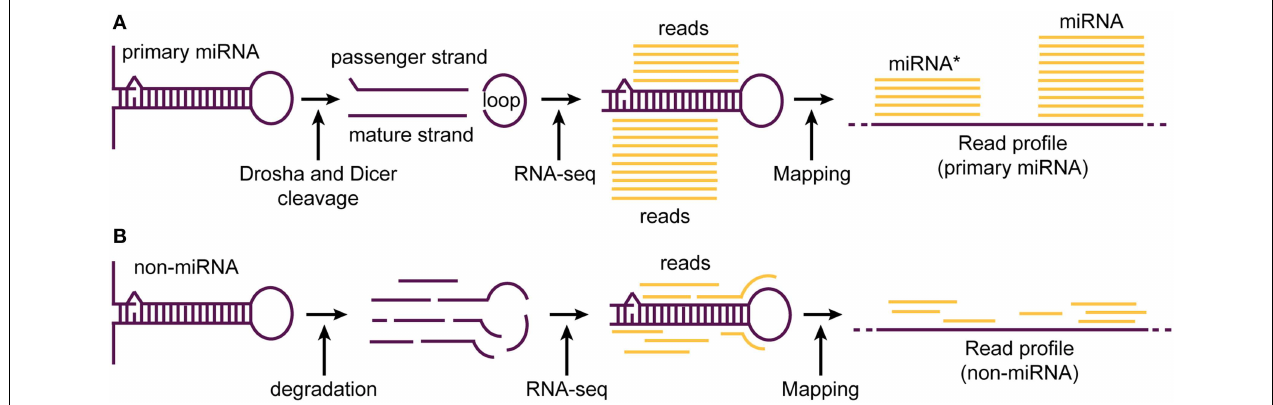
mapped to the reference genome, reads corresponding to miRNA and star miRNA align in a pattern (read profile) consisting of two major read clusters sharing almost the same 5 ′ end base position. (B) In contrast to precise processing of miRNA transcript, non-miRNA transcripts are processed at random base positions. This leads to the generation of many RNA fragments of no fixed length. When sequenced during RNA-seq experiments and mapped to the reference genome, the generated read profile consists of randomly placed reads having high variability in their 5 ′ end base